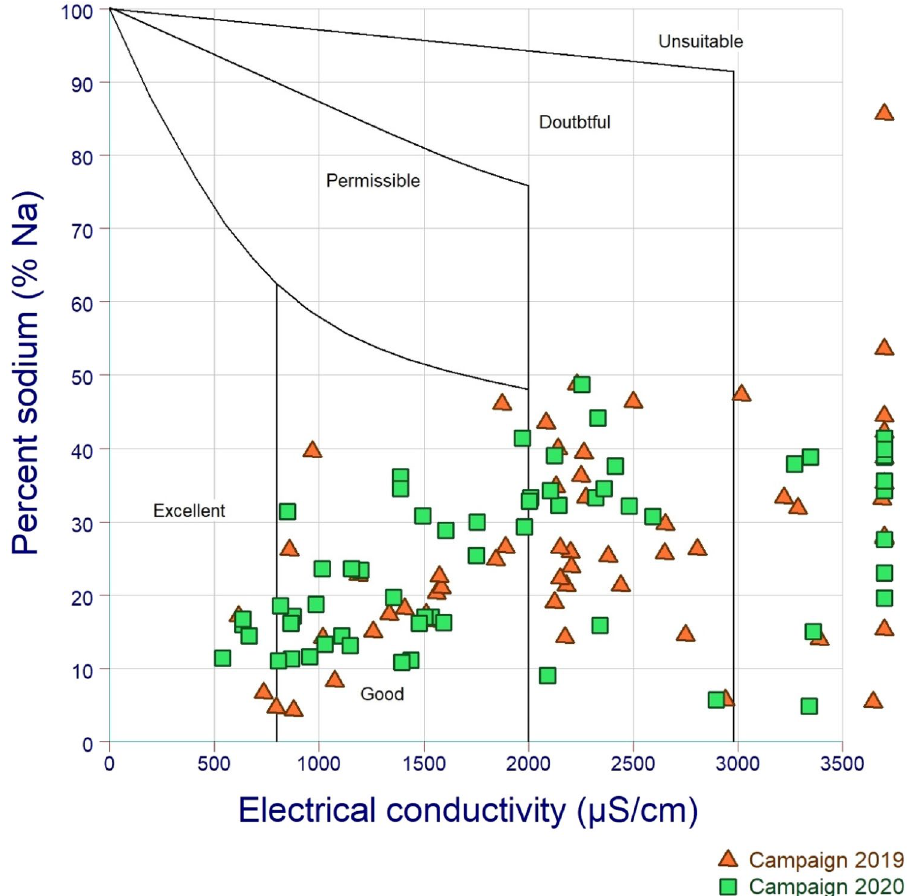
Fig. 6 Suitability of groundwa- ter for irrigation in the Wilcox